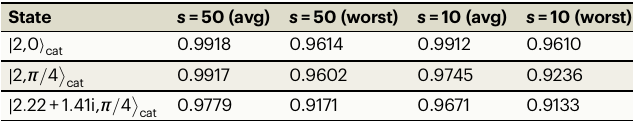
Table 3 | Performances of GQNQ on cat states as an unsu- pervised learner